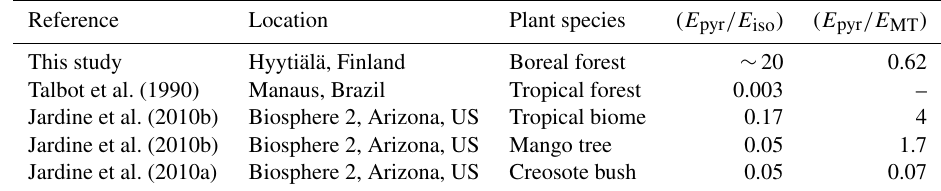
Table 1. Emission rate of pyruvic acid ( E pyr ) relative to isoprene ( E iso ) and MT ( E MT